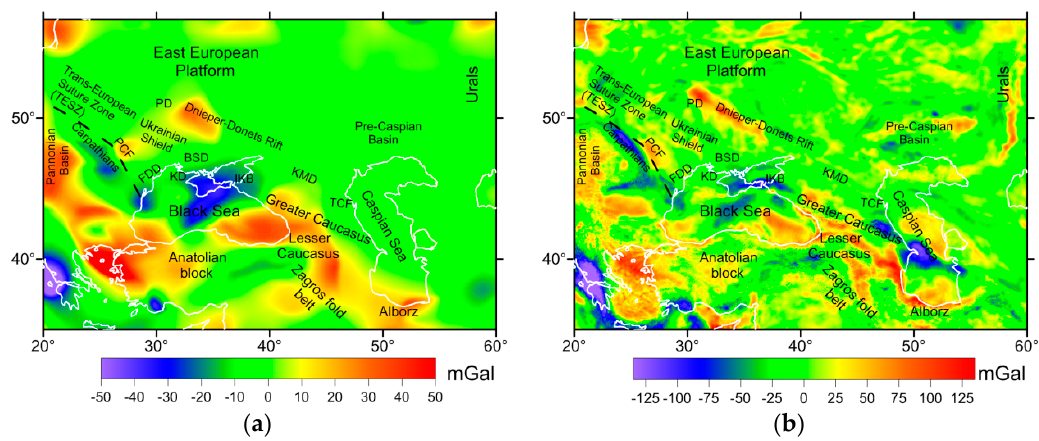
Figure 6. ( a ) Decompensative correction for the isostatic gravity anomalies; ( b ) decompensative gravity anomalies.